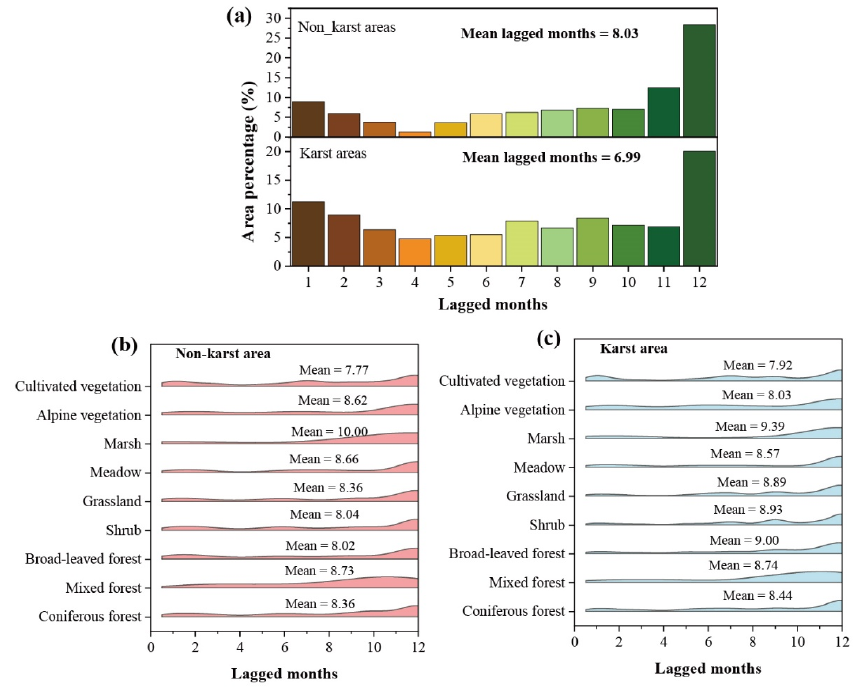
Figure 15. ( a ) Area percentage at different lagged time scales in karst and non-karst areas. ( b ) Time- lagged months of different vegetation types in karst areas. ( c ) Time-lagged months of different vegetation types in non-karst areas.